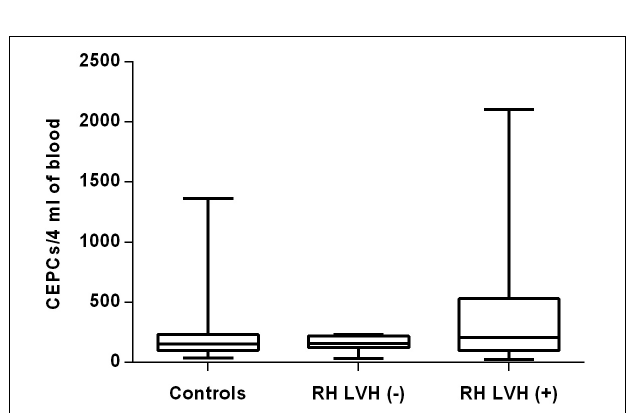
FIGURE 4 | CECs number in patients with and without LVH belonging to RH group. Box and whisker plots show median (central line), upper and lower quartiles (box) and range excluding outliers (whiskers). Data were analyzed using Kruskal-Wallis test followed by the Dunn’s multiple comparison test. P ≤ 0.05 was considered statistically significant.